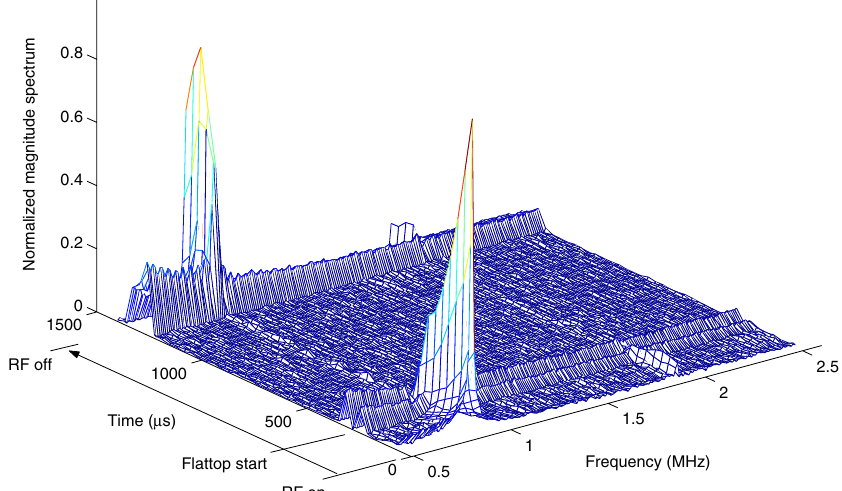
FIG. 14. (Color) 5 = 6 (cid:3) mode excited by the switching of rf power. The measurement was made on SC cavity SCL-13a running with no feedback control (open loop).